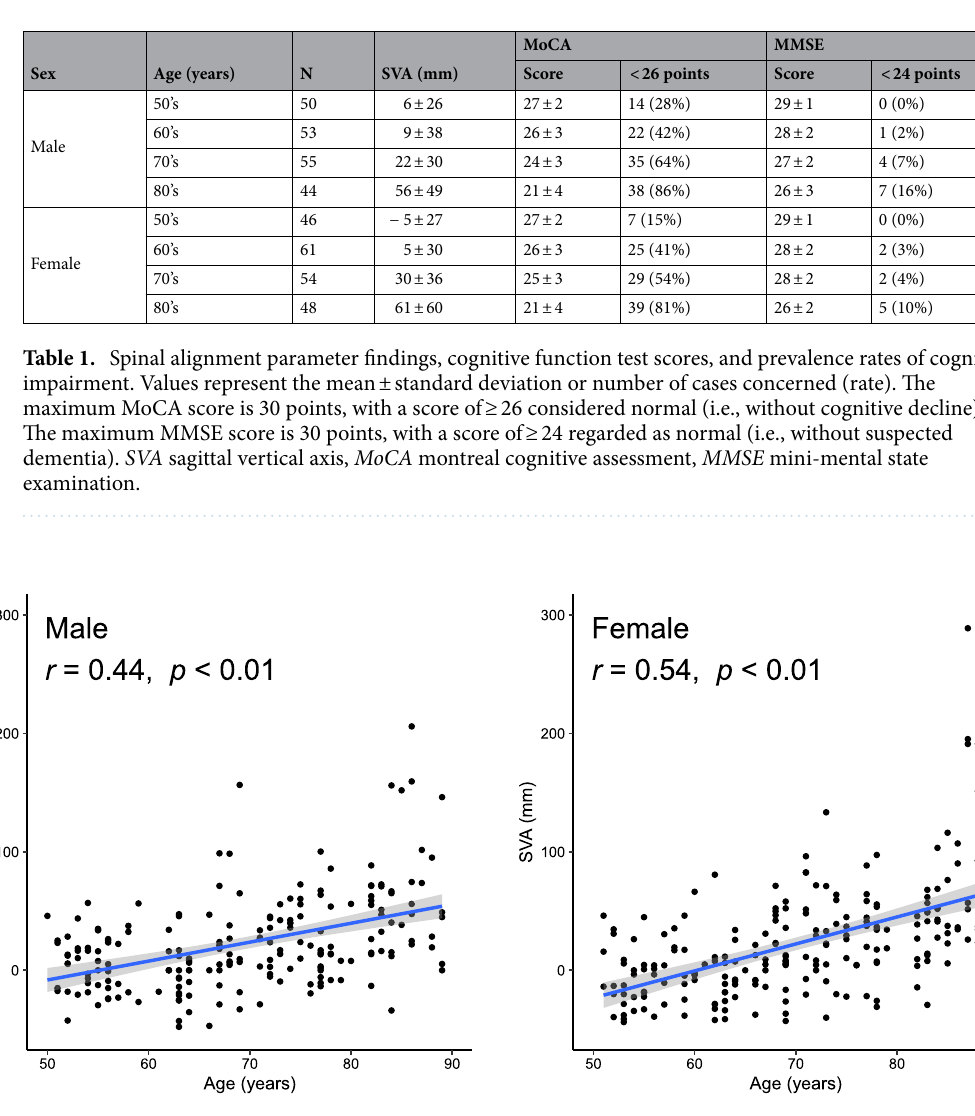
Figure 1. Distributions of sagittal vertical axis with age. r denotes Pearson’s correlation coefficient between sagittal vertical axis and age. SVA sagittal vertical